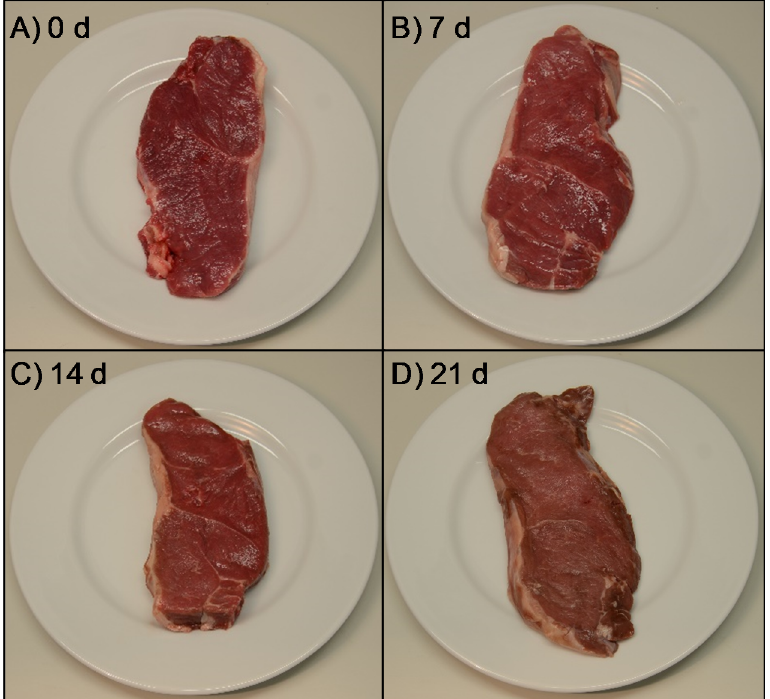
Figure 3. Representative photographs of non-aged ( A ) and aged horse longissimus thoracis and lumborum steaks (( B ) 7 days, ( C ) 14 days and ( D ) 21 days).